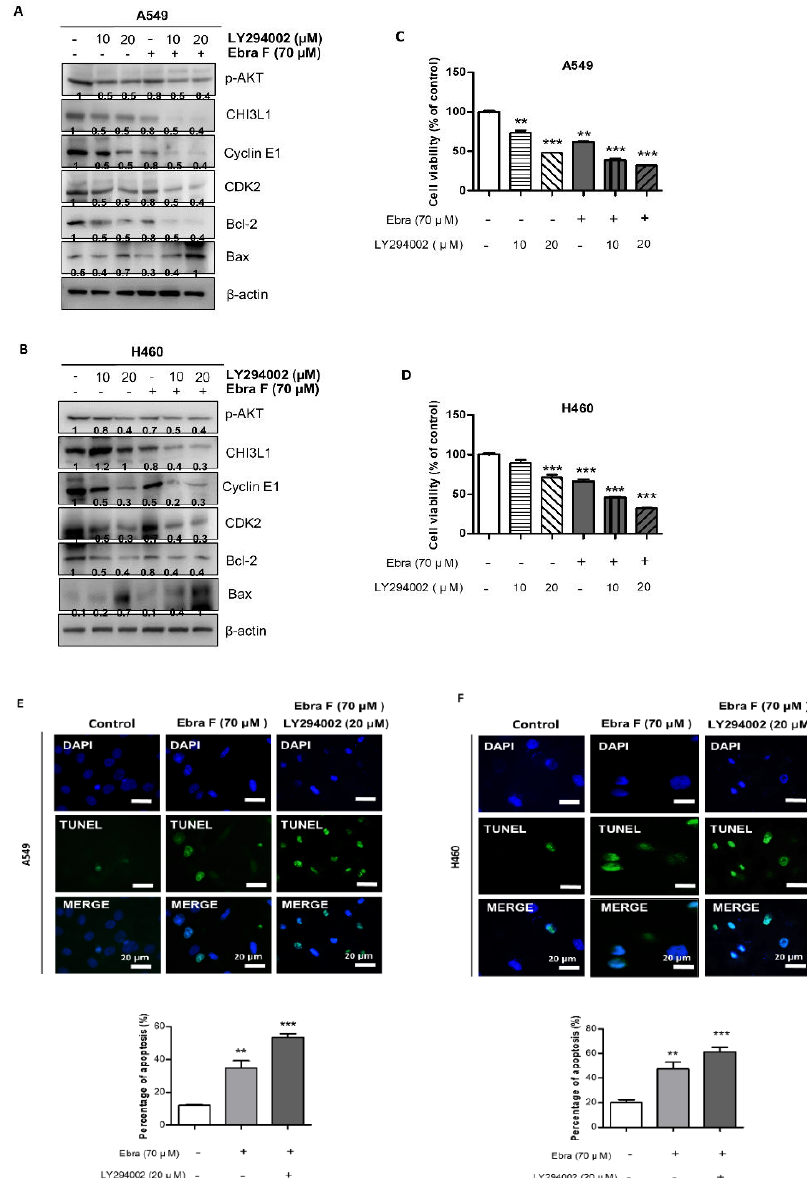
Figure 8. Combination treatment with ebractenoid F and AKT inhibitor LY294002 on cell growth, apoptosis, as well as expression of cell cycle and death signal protein. After the lung cancer cells were pretreated with AKT inhibitor LY294002, the expression levels of cell cycle (Cyclin E and CDK2) and apoptosis-related proteins (Bcl-2 and Bax) were detected by Western blot analysis ( A , B ). β -actin protein was used as an internal control. Each band is representative of three experiments. The concentration-dependent effects of ebractenoid F and LY294002 on A549 and H460 cells after 24 h of treatment were assessed via the cell viability assay (MTT assay) ( C , D ). The data were expressed as the mean ± S.D. of three experiments. **, p < 0.01; ***, p < 0.001; n.s. (not statistically significant) indicates statistically significant differences from the control group. Treatment of lung cancer cells with the combination of ebractenoid F and LY294002 for 24 h was first performed by their labeling with the DAPI and TUNEL stains. Fluorescent microscopy images of TUNEL assay. DAPI staining (blue) was used to identify cell nuclei; TUNLE-positive cells are in green. The apoptotic index was determined as the DAPI-stained TUNEL-positive cell number/total DAPI stained cell number (magnification, 100 × ) ( E , F ). The values represent the means ± S.D. of three experiments. **, p < 0.01; ***, p < 0.001; n.s. (not statistically significant) indicates statistically significant differences from the control cells.